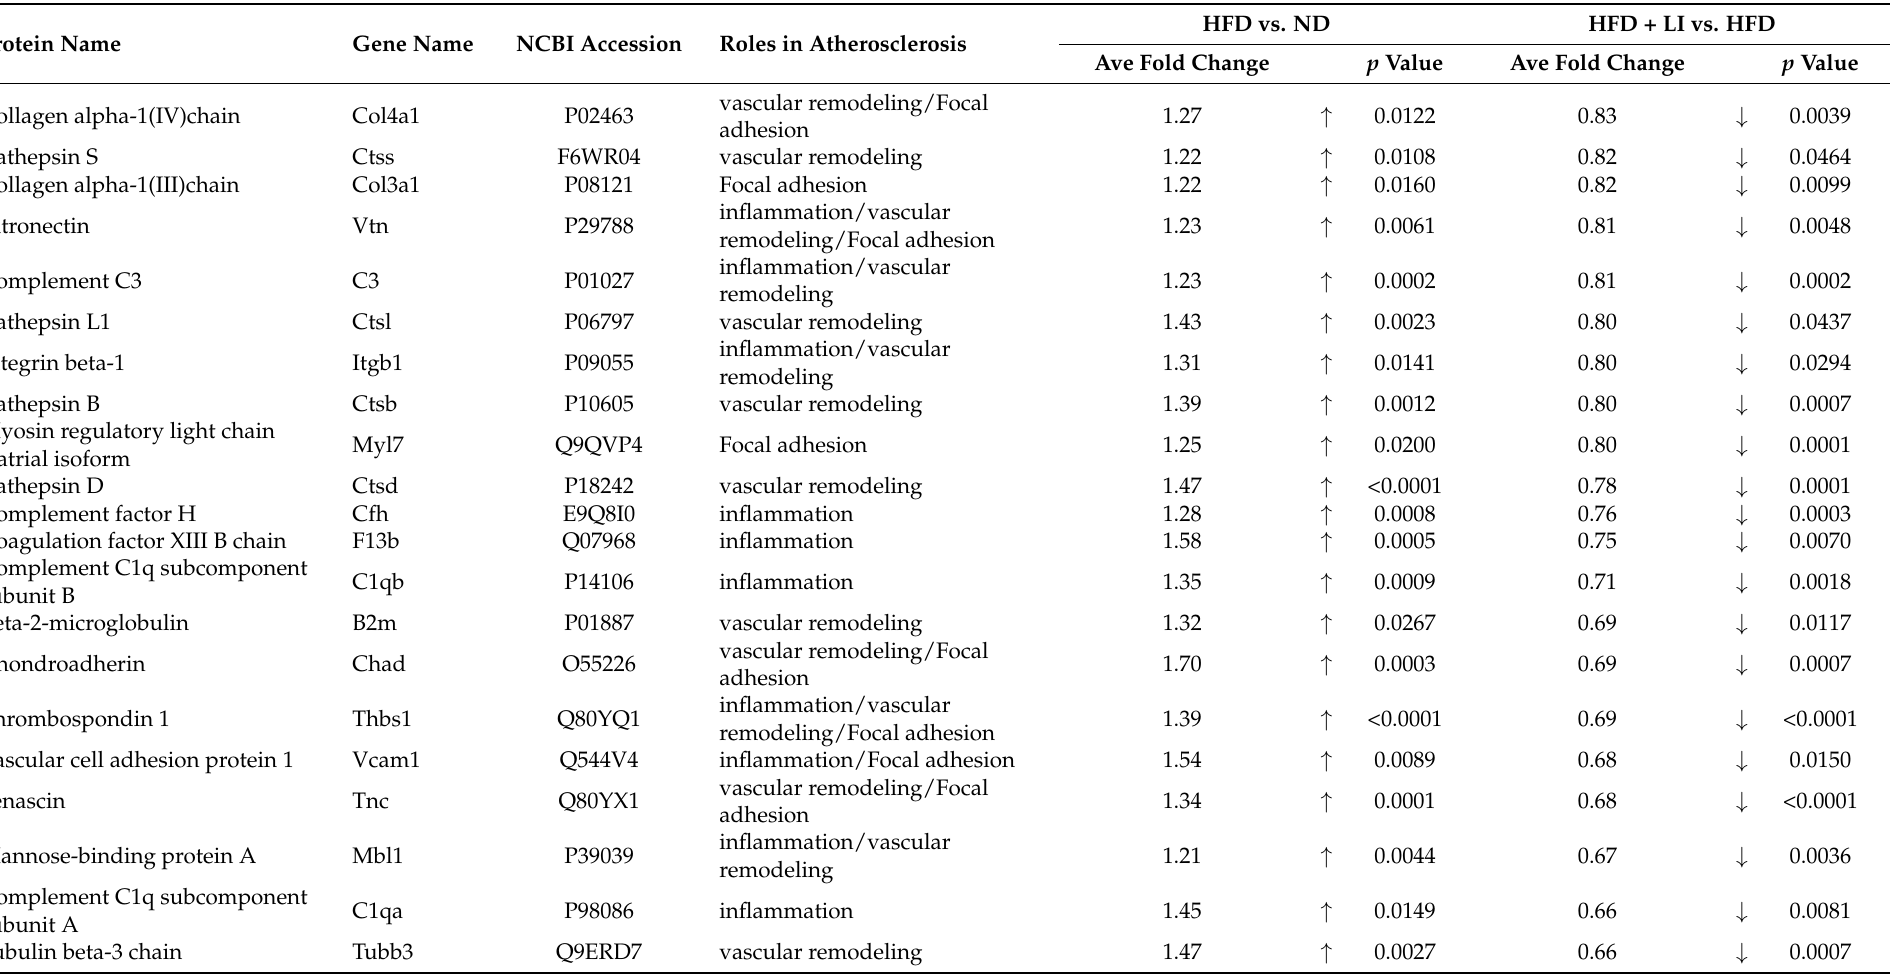
Table 1. iTRAQ analysis identified the differentially expressed proteins involved in aortic inflammation, vascular remodeling and focal adhesion in murine aortic